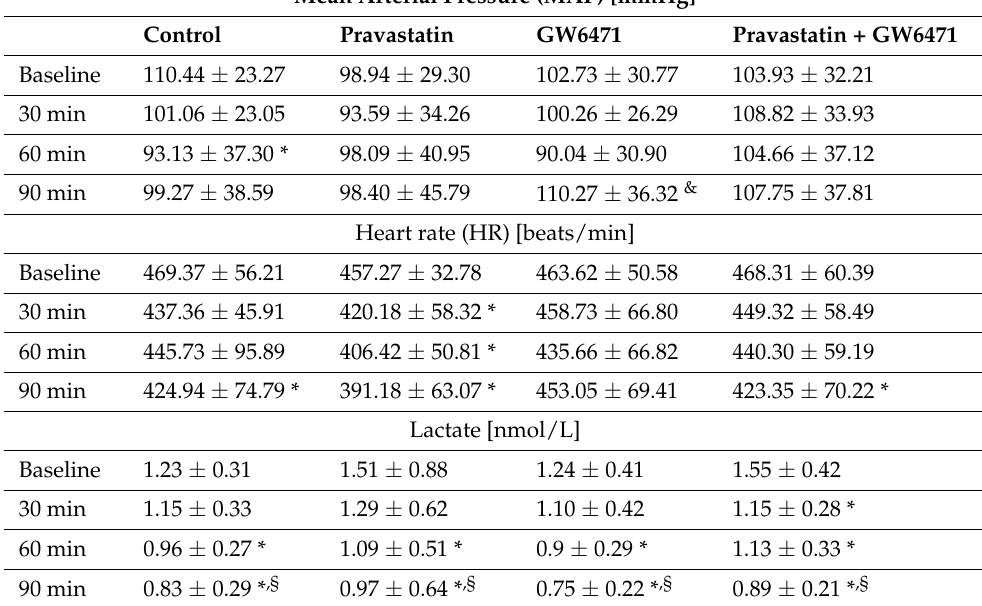
Table 1. Mean arterial blood pressure (MAP), heart rate (HR) and lactate concentration in control sep- tic animals (control) and after treatment with pravastatin (Pravastatin), PPAR- α -antagonist GW6471 (GW6471) and a combination with both drugs (Pravastatin + GW6471). n = 10, * p < 0.05 vs. baseline, § p < 0.05 vs. 30 min, & p < 0.05 vs. 60 min.